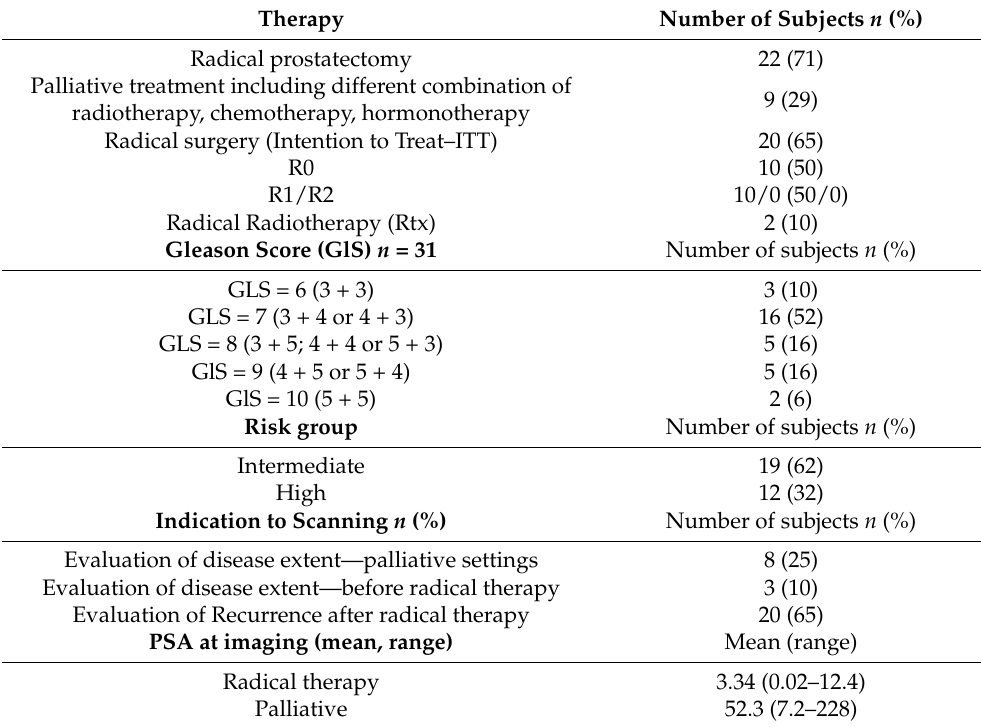
Table A2. Summarized clinical, pathology and biochemical data for the group of patients with PCa included in the study.